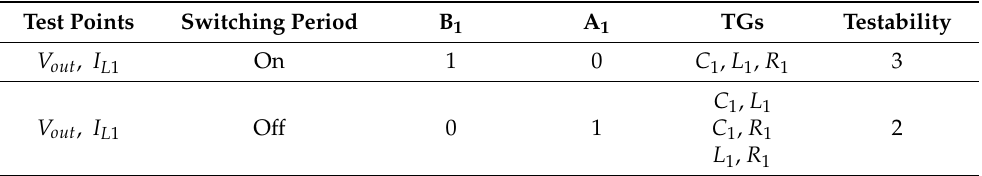
Table 2. Testability analysis in the frequency domain for a buck converter using output voltage and inductor current